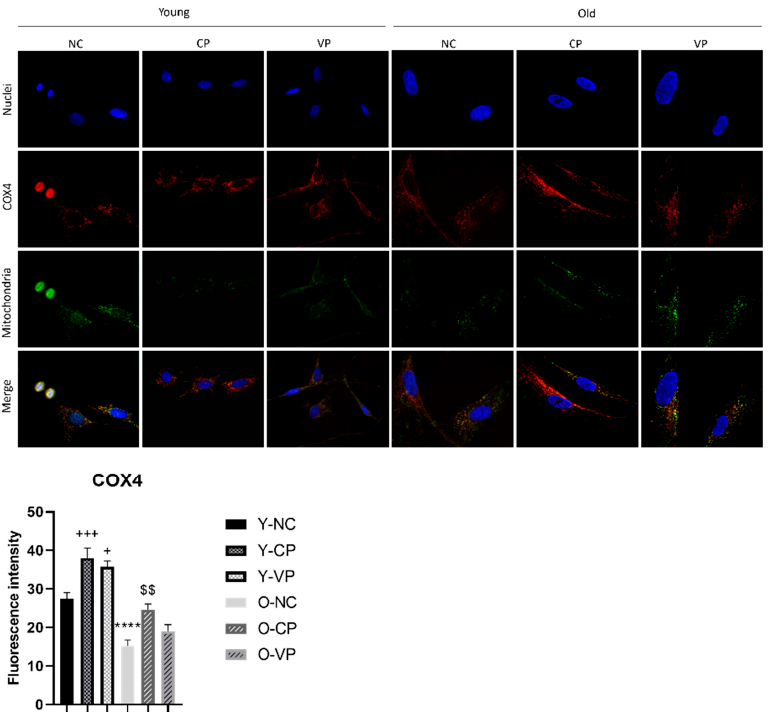
Figure 6. Double immunolabeling for protein COX4 (red fluorescence) and mitochondria (green fluorescence); DNA was stained with Hoechst 33258 (blue fluorescence). 60× magnification; scale bar: 10 μ m. Histograms showing the analysis of COX4 fluorescence intensity; Anova one-way test: p = 0.01; **** p < 0.0001, statistical significance between untreated young NHDF (Y-NC) and old untreated NHDF (O-NC); +++ p < 0.001, statistical significance between untreated young NHDF (Y-NC) and young NHDF treated with CP extract (Y-CP); + p < 0.05, statistical significance between young NHDF treated with VP and negative control; $$ p < 0.01, statistical significance between old NHDF treated with CP and old NHDF untreated.